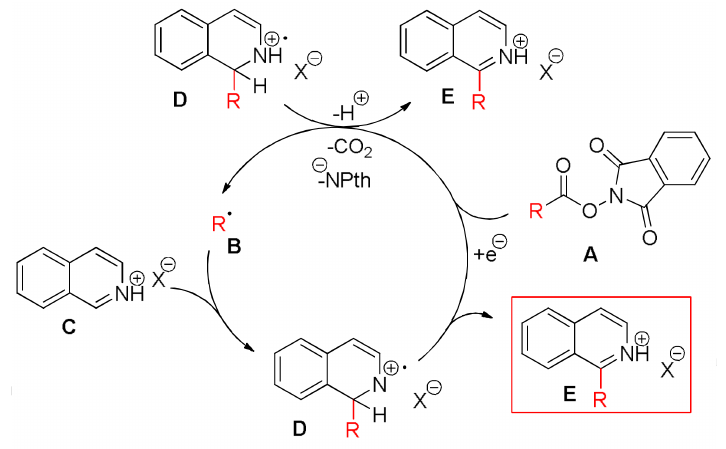
Scheme 3. Proposed mechanism for the radical-chain reaction without a